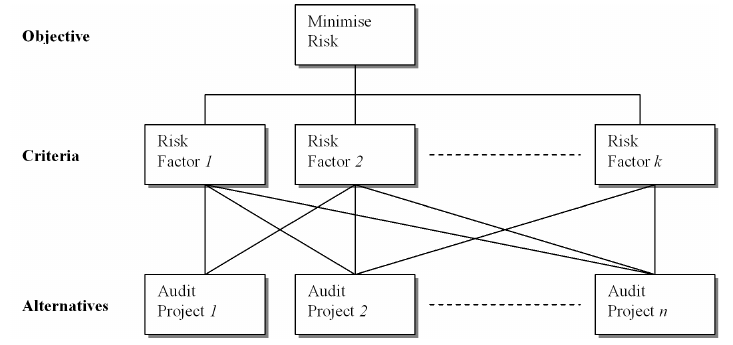
Figure 2: Analytical